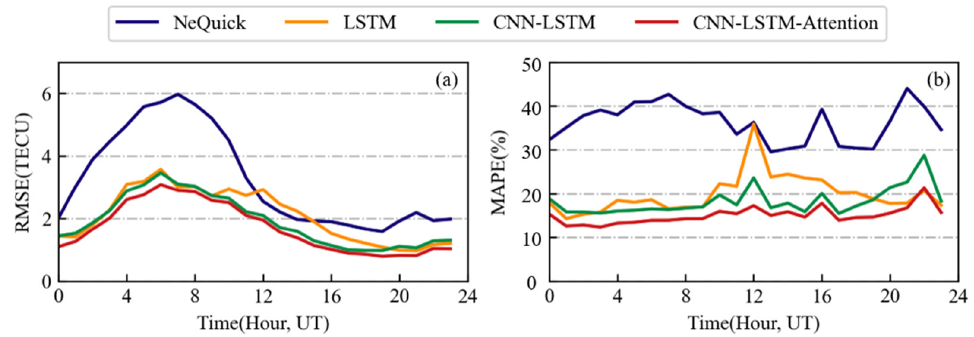
Figure 9. The forecasted averages of GNSS measured values (gray bars), NeQuick (blue bars), LSTM (yellow bars), CNN-LSTM (green bars), and CNN-LSTM-Attention (red bars) models from 12 months in the test set.